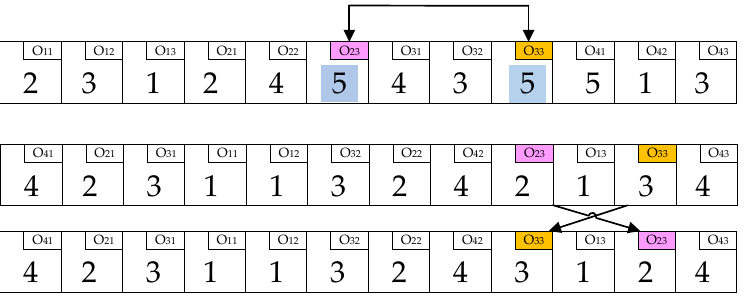
Figure 5. Schematic diagram of the same-bottleneck machine neighborhood search.